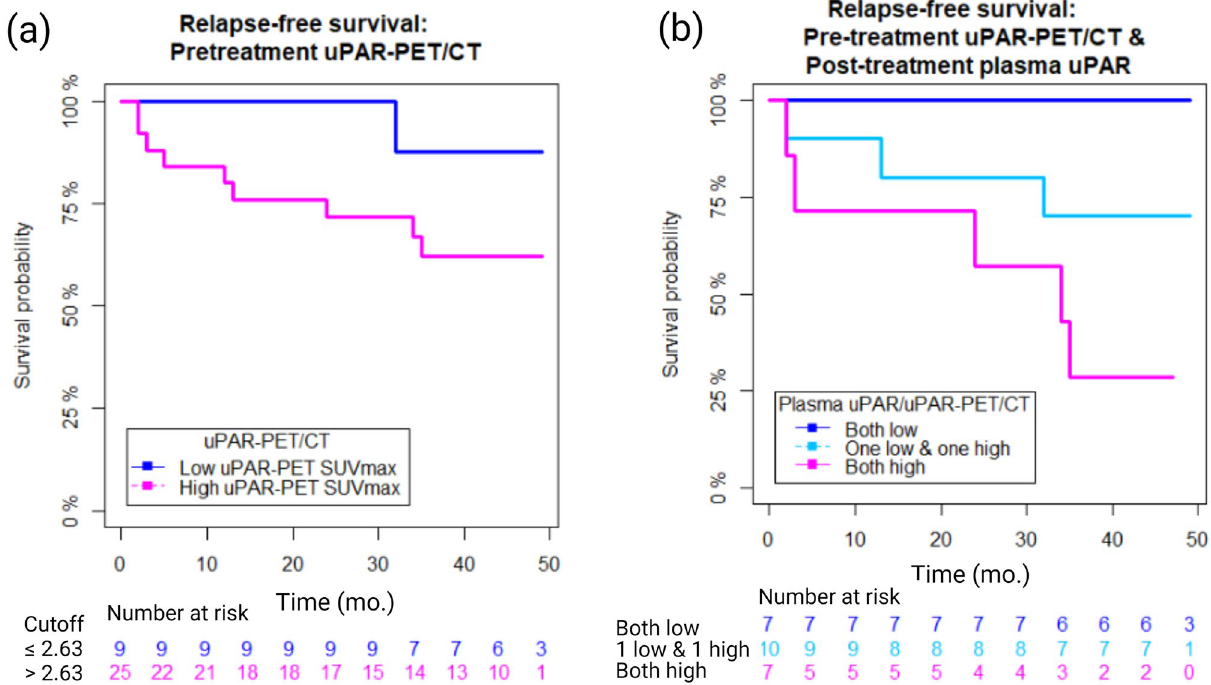
Figure 3. Relapse-free survival according to ( a ) pre-treatment uPAR-PET alone and ( b ) pretreatment uPAR- PET in combination with post-treatment plasma uPAR results in head and neck squamous cell carcinoma patients following radiotherapy treatment. (A) dark blue indicates an SUVmax below cut-off and magenta an SUVmax above cut-off. (B) Congruent low uPAR measurements (dark blue), congruent high uPAR measurements (magenta) and incongruent uPAR measurements (turquoise), with one low and one high estimate on either of the modalities. The uPAR levels determined by liquid biopsies and uPAR-PET were dichotomized according to the established